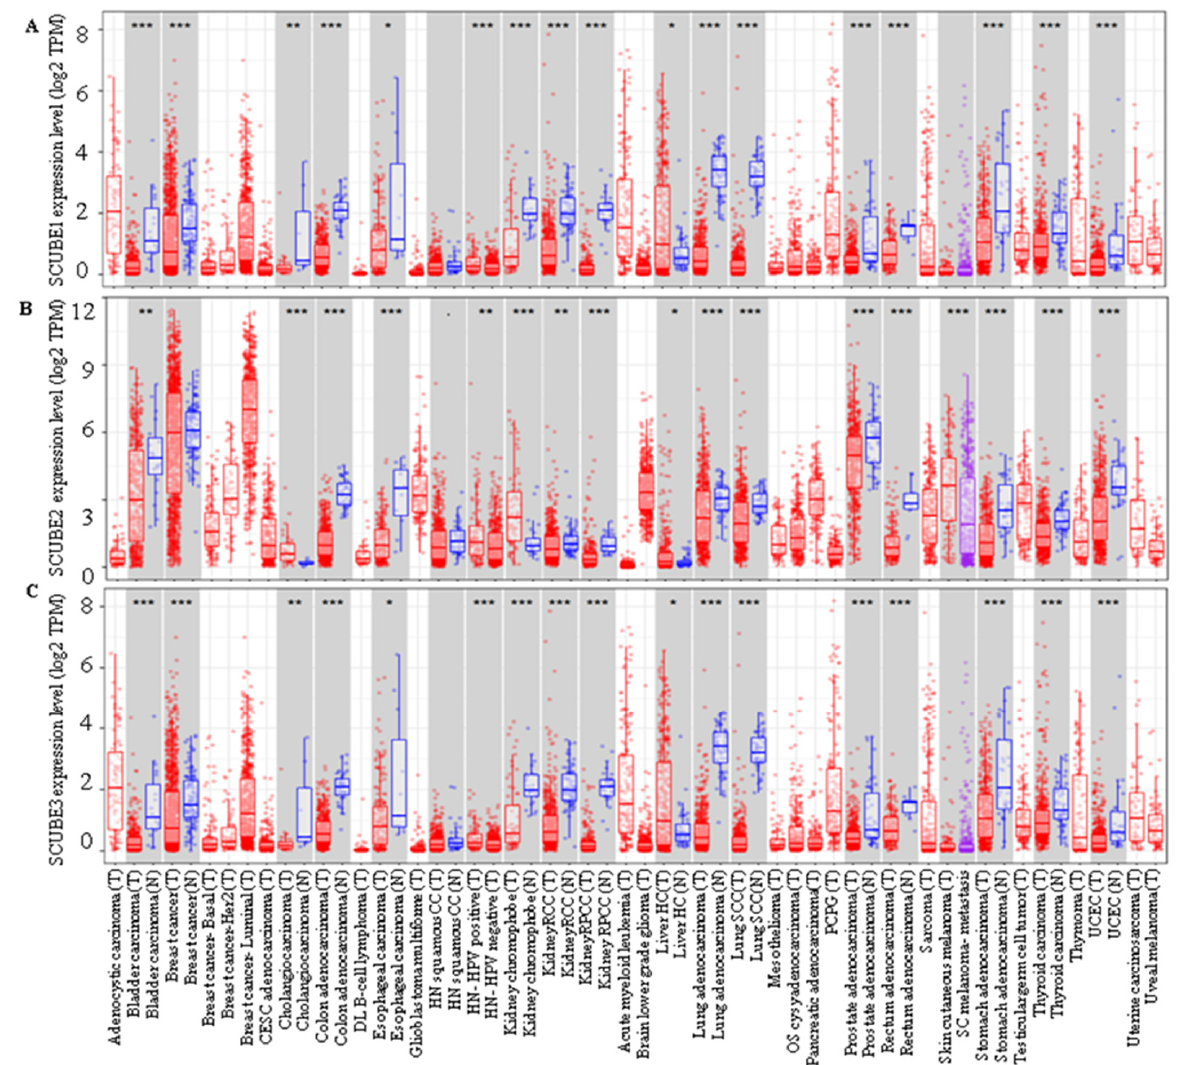
Figure 2. Expression of SCUBE family members in various human tumors. ( A ) SCUBE1, ( B ) SCUBE2, and ( C ) SCUBE3 expression in different cancer types in comparison to adjacent normal tissue. Data extracted from TCGA database determined by tumor immune estimation resource (TIMER) presented as log2-TPM. TPM denotes transcript count per million.